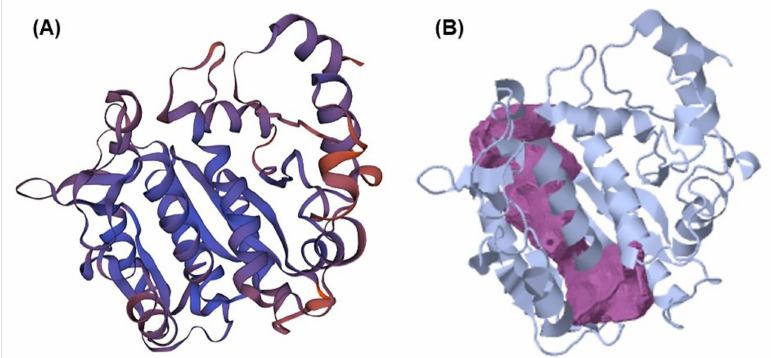
Figure 2. ( A ) Homology model of beta-tubulin by Swiss Model. ( B ) The detected cavity with the strong-binding site of beta-tubulin.